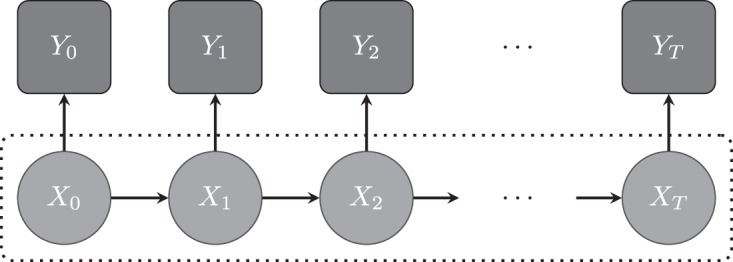
A graphical representation of the state-space model for single cell imaging data. The arrows depict conditional dependencies between nodes, where square nodes are observed variables and circular nodes are unobserved. The observed light intensities, \documentclass[12pt]{minimal}
\usepackage{amsmath}
\usepackage{wasysym}
\usepackage{amsfonts}
\usepackage{amssymb}
\usepackage{amsbsy}
\usepackage{upgreek}
\usepackage{mathrsfs}
\setlength{\oddsidemargin}{-69pt}
\begin{document}
}{}$Y_t$\end{document}, are conditionally independent given the unobserved latent states \documentclass[12pt]{minimal}
\usepackage{amsmath}
\usepackage{wasysym}
\usepackage{amsfonts}
\usepackage{amssymb}
\usepackage{amsbsy}
\usepackage{upgreek}
\usepackage{mathrsfs}
\setlength{\oddsidemargin}{-69pt}
\begin{document}
}{}${\textbf{X}}_t:= (M_t, P_t)$\end{document} consisting of reporter mRNA, \documentclass[12pt]{minimal}
\usepackage{amsmath}
\usepackage{wasysym}
\usepackage{amsfonts}
\usepackage{amssymb}
\usepackage{amsbsy}
\usepackage{upgreek}
\usepackage{mathrsfs}
\setlength{\oddsidemargin}{-69pt}
\begin{document}
}{}$M_t$\end{document}, and reporter protein, \documentclass[12pt]{minimal}
\usepackage{amsmath}
\usepackage{wasysym}
\usepackage{amsfonts}
\usepackage{amssymb}
\usepackage{amsbsy}
\usepackage{upgreek}
\usepackage{mathrsfs}
\setlength{\oddsidemargin}{-69pt}
\begin{document}
}{}$P_t$\end{document}, levels at time \documentclass[12pt]{minimal}
\usepackage{amsmath}
\usepackage{wasysym}
\usepackage{amsfonts}
\usepackage{amssymb}
\usepackage{amsbsy}
\usepackage{upgreek}
\usepackage{mathrsfs}
\setlength{\oddsidemargin}{-69pt}
\begin{document}
}{}$t$\end{document}. Moreover, the latent states follow a Markov jump process with \documentclass[12pt]{minimal}
\usepackage{amsmath}
\usepackage{wasysym}
\usepackage{amsfonts}
\usepackage{amssymb}
\usepackage{amsbsy}
\usepackage{upgreek}
\usepackage{mathrsfs}
\setlength{\oddsidemargin}{-69pt}
\begin{document}
}{}${\textbf{X}}_t$\end{document} depending only upon the previous states \documentclass[12pt]{minimal}
\usepackage{amsmath}
\usepackage{wasysym}
\usepackage{amsfonts}
\usepackage{amssymb}
\usepackage{amsbsy}
\usepackage{upgreek}
\usepackage{mathrsfs}
\setlength{\oddsidemargin}{-69pt}
\begin{document}
}{}${\textbf{X}}_{t-1}$\end{document}.